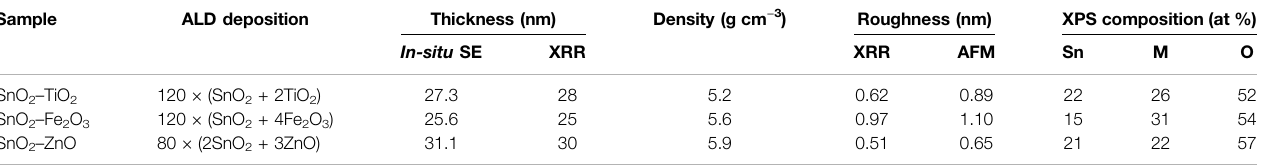
TABLE 2 | The thickness, density, roughness and XPS composition of SnO 2 – TiO 2 , SnO 2 – Fe 2 O 3 , and SnO 2 – ZnO composite thin- fi lms by ALD.